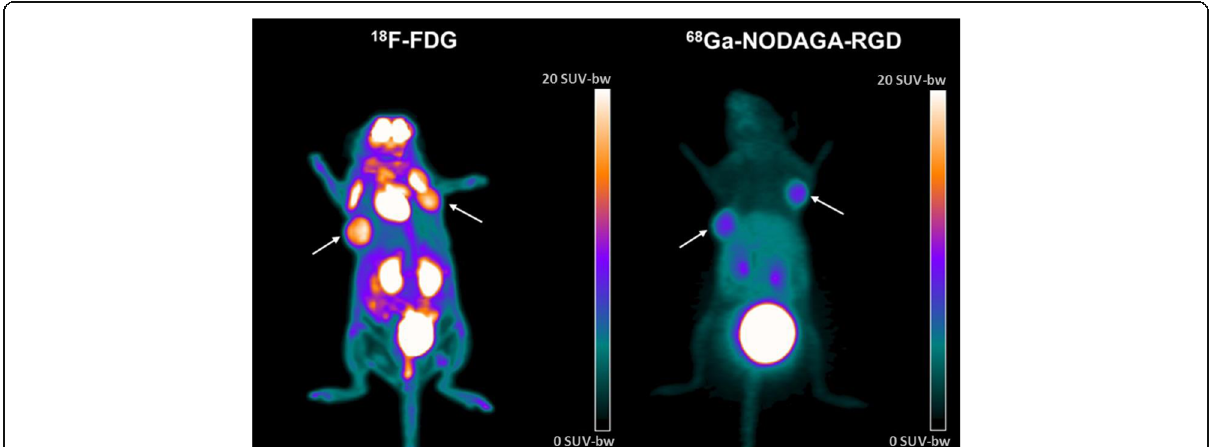
Fig. 4 Example of superimposed Maximal Intensity Pixel images corresponding to the 2 nd hour of PET recording and obtained in the same xenograft mouse with 18 F-FDG (left panel) and with 68 Ga-NODAGA-RGD (right panel). The two tumors are indicated with white arrows, and the color scale is expressed in SUV values